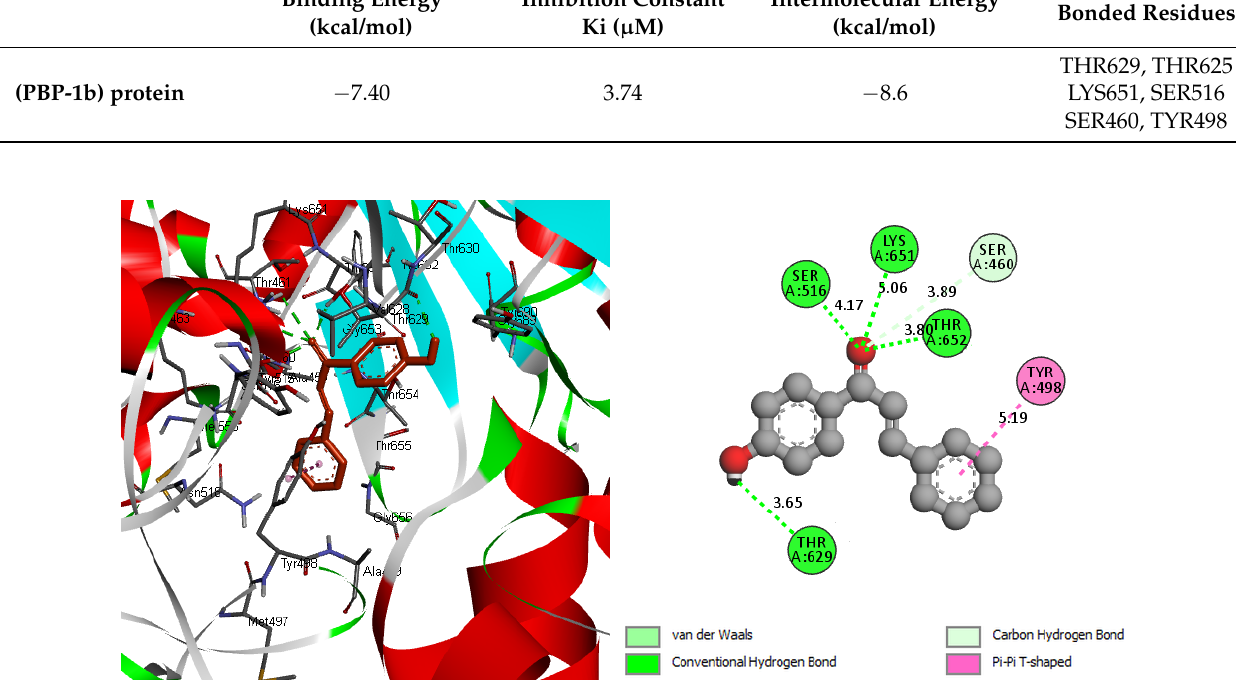
Figure 7. The binding interactions of 1-(4-Hydroxyphenyl)-3-phenylprop-2-en-1-one ligand with PBP 1 of S. aureus